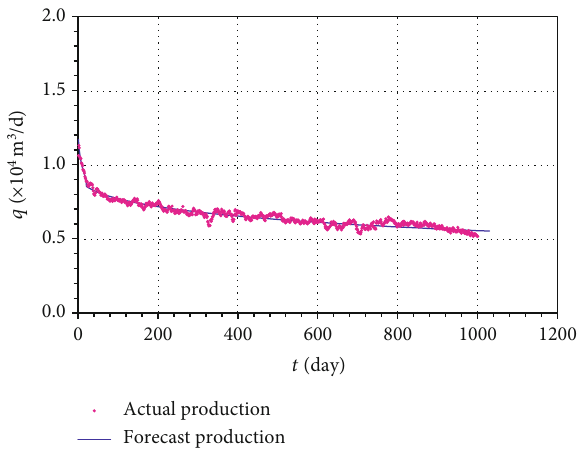
Figure 9: q vs. t matching plot for A well. g